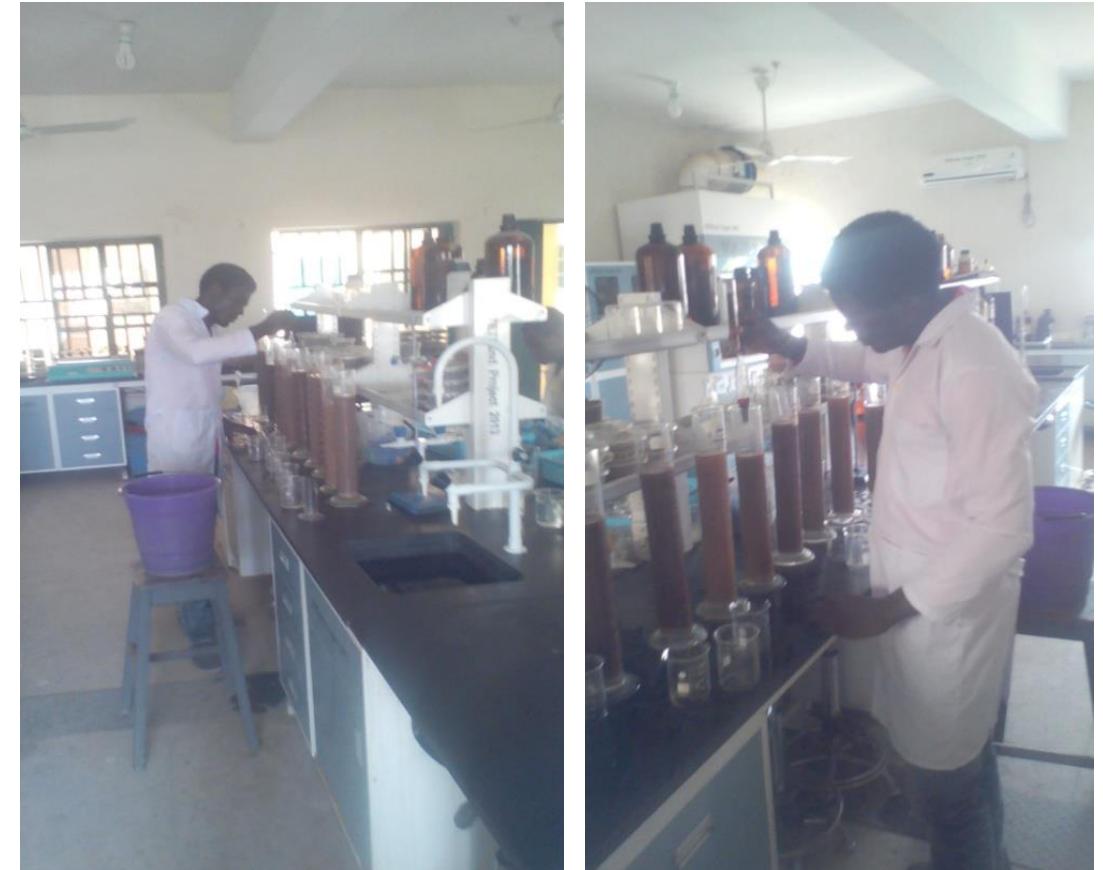
Fig. 3. The particle size analysis in the